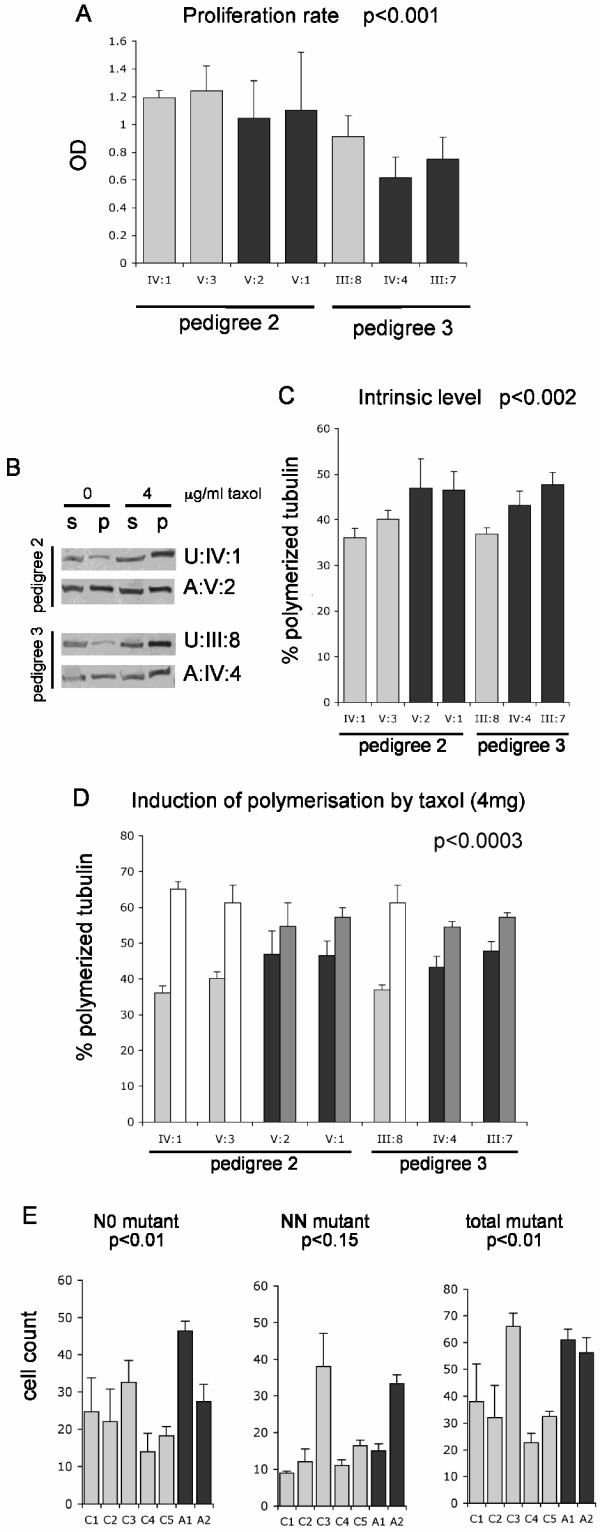
Functional assays on FPD-AML cell lines. A. The results of a BrdU proliferation assay are indicated for each cell line. Dark bars indicate affected individuals. The standard errors of two independent replicates are shown. A two-way ANOVA resulted in a significant p-value (p < 0.001) between affected and unaffected individuals. B. Examples of the tubulin polymerization assay for an affected and an unaffected individuals in each family. s:soluble tubulin; p:polymerized tubulin. C. The percentage of polymerized tubulin is shown for each cell line. Dark bars indicate affected individuals. The standard errors of three independent replicates are indicated. A two-way ANOVA resulted in a significant p-value (p < 0.002) between affected and unaffected individuals. D. Percentage of polymerized tubulin in the same cell lines before (darker left bars) and after (second bars) induction of polymerization by Taxol. A significant smaller induction is observed in affected individuals (dark bars) as demonstrated by an ANOVA (p < 0.0003). E. Glycophorin A assay. The numbers of N0 (loss of the M allele), NN (mutation changing M to N allele) or total mutant (both N0 and NN) cells are indicated for each individual. The standard errors of three to five technical replicates are indicated. Dark bars represent affected individuals (A1-A2). The control C5 is the unaffected sister of patient A1. ANOVAs were performed for each kind of mutation and the p-values are indicated.